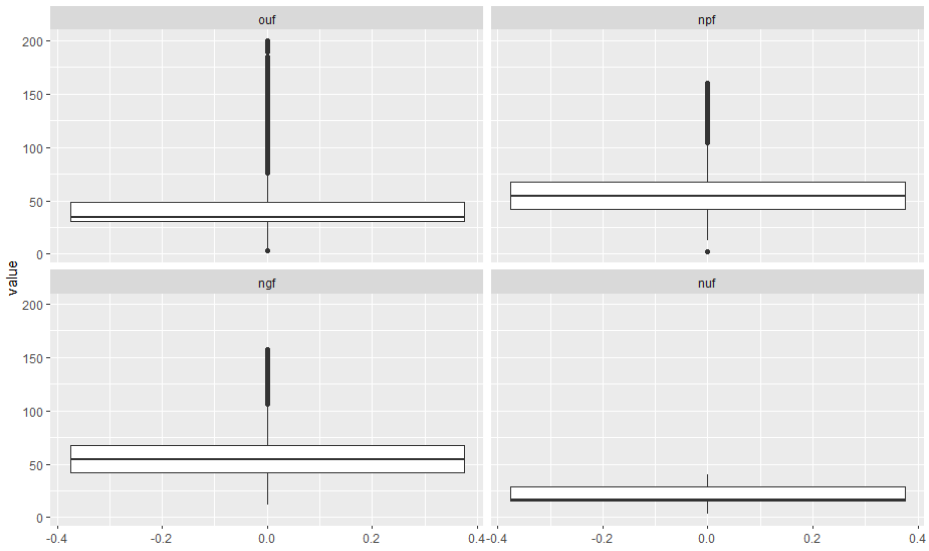
Figure 3. A box plot of the variability of the recorded parameters after rejecting extreme values. Source: Own study.